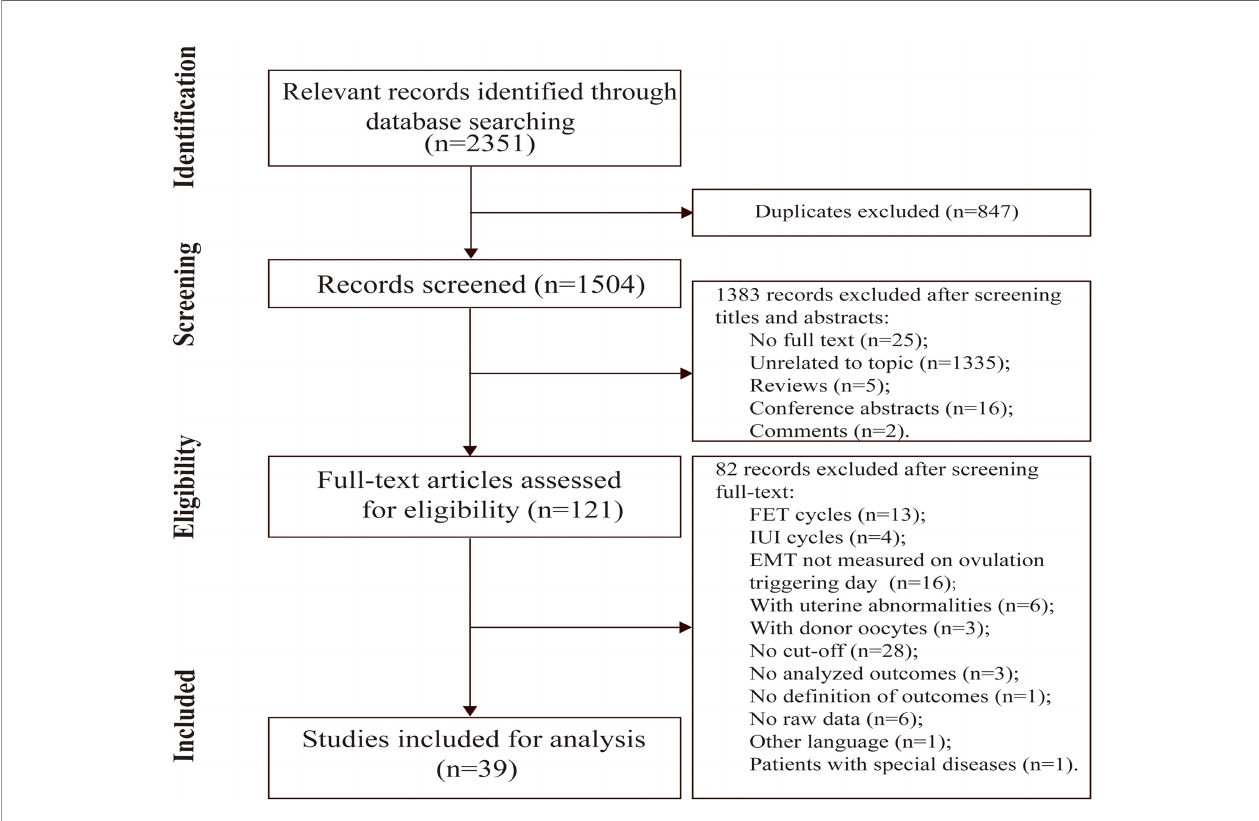
FIGURE 1 | Flow chart of searching and screening